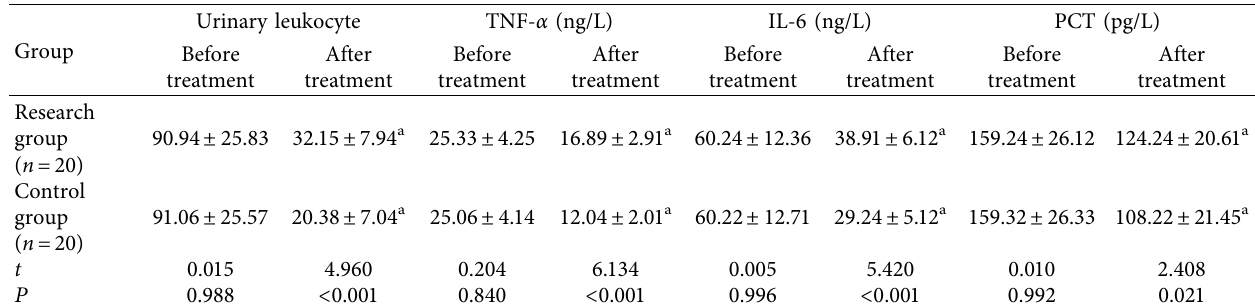
Table 6: Comparison of urinary leukocytes and serum inflammatory factors in patients with different treatment methods before and after treatment ( x ±